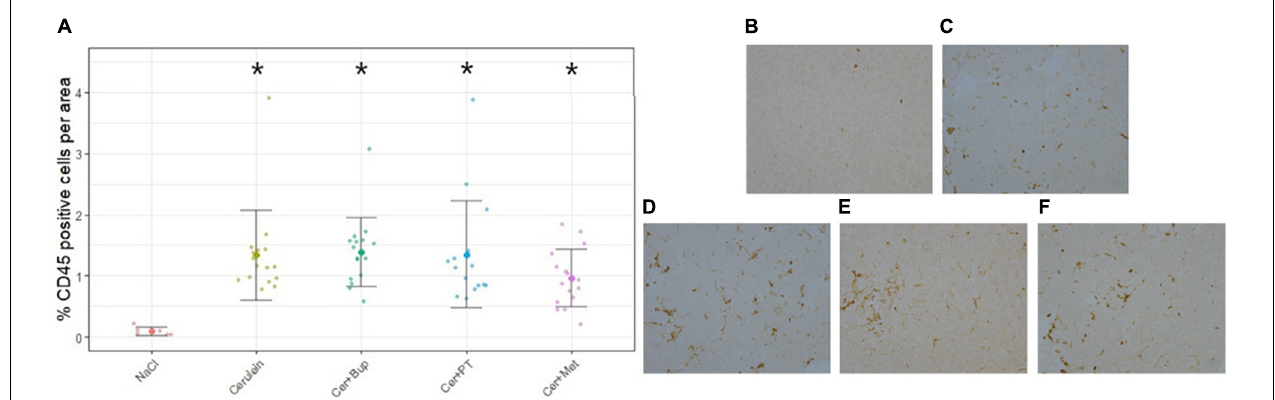
FIGURE 2 | Assessment of pancreatic inflammation with CD45 immunostaining displayed as percentage of CD45 positive cells per area (A) . Wilcoxon post hoc test detected significant differences between the NaCl group and the groups receiving Cerulein. The Cerulein group and groups with Cerulein and an analgesic did not differ from each other. Examples of CD45 immunostaining of the different treatment groups: (B) NaCl, (C) Cerulein, (D) Cerulein with Buprenorphine, (E) Cerulein with Paracetamol and Tramadol and, (F) Cerulein with Metamizole. Data are presented as scatter dot plots with mean ± SD. *Significant ( p ≤ 0.05) differences from NaCl treated animals. NaCl n = 6, Cer n = 17, Cer + Bup n = 16, Cer + PT n = 15, Cer + Met n = 16.